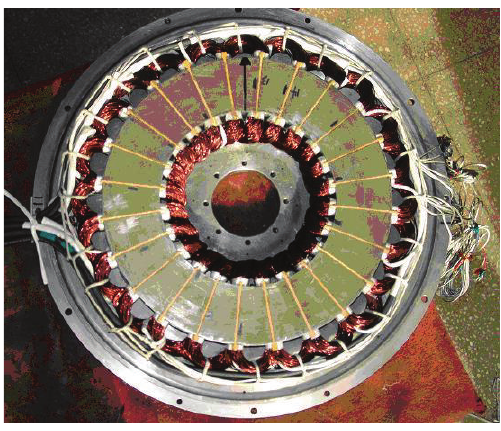
Figure 5: Stator system for 15kW motor example of a figure caption.